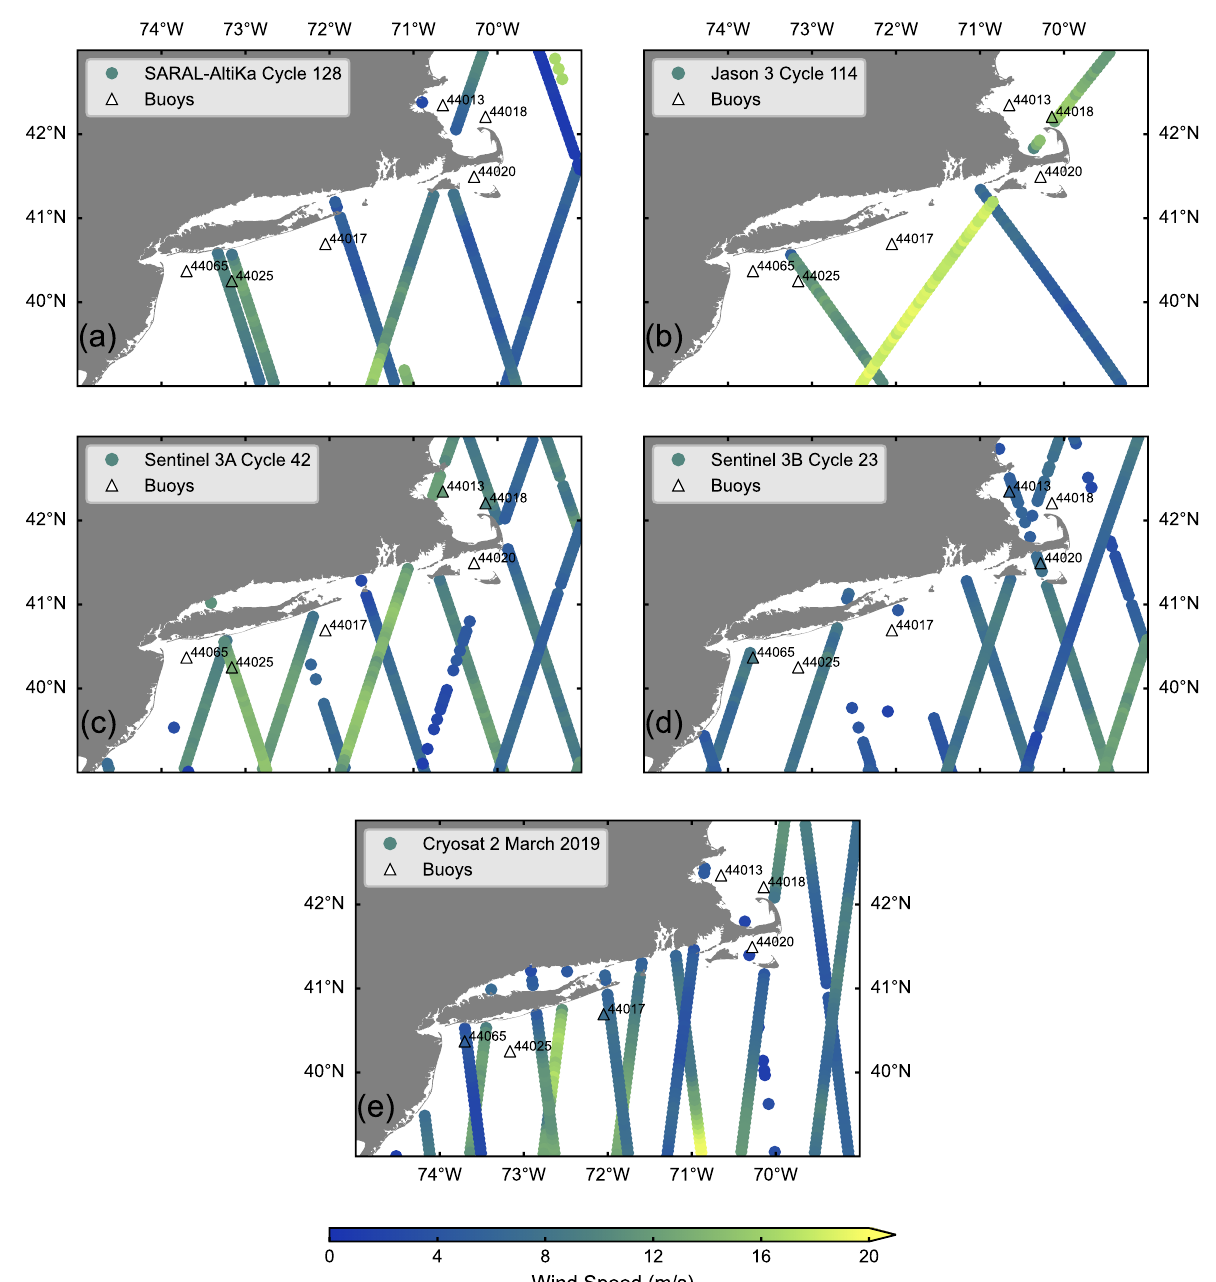
Figure 2. The quality-controlled altimeter WS observations of ( a ) SARAL-AltiKa, ( b ) Jason 3, ( c ) Sentinel 3A, ( d ) Sentinel 3B and ( e ) Cryosat 2 over the Northeast US during March 2019. The altimeter data are matched within a 10 km sampling radius and a time window of 30 min with the collocated WS buoy data, depicted with colored triangles. The white triangles represent either the buoys outside the sampling radius or those without available data due to the gaps in their time